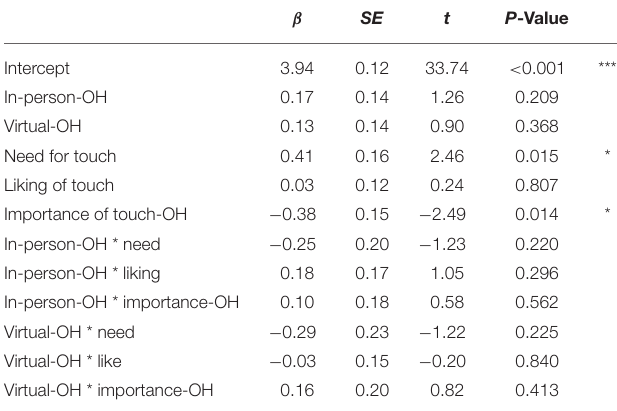
TABLE 4 | Prediction of burden through physical distancing policies by contact frequencies and appraisal of social touch. β